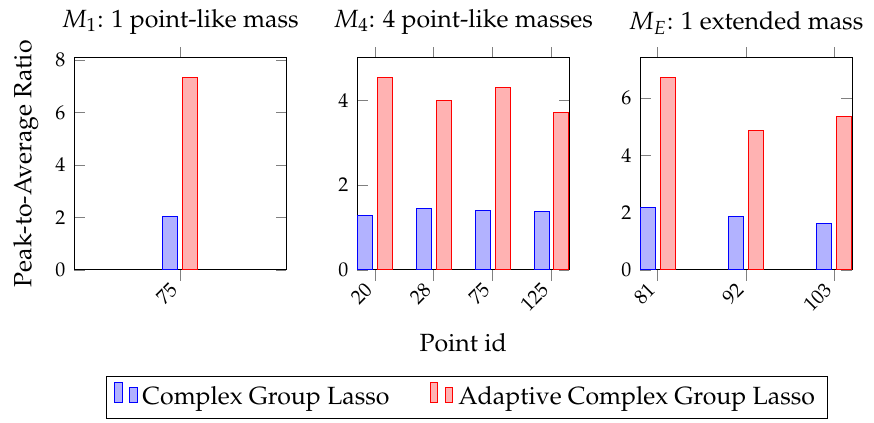
Figure 5. Peak-to-Average Ratio with Complex Group Lasso and Adaptive Complex Group Lasso for the three damage